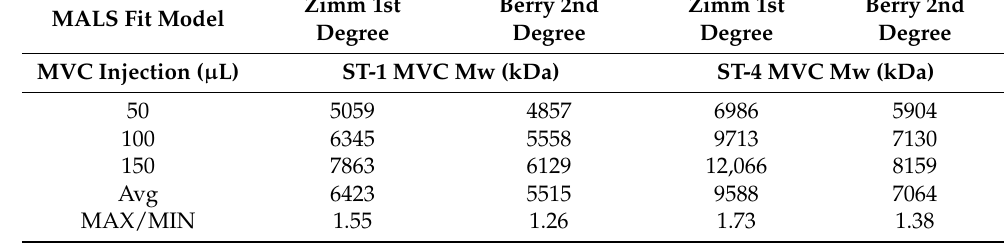
Figure 4. Zimm 1st order fit ( a ) vs. Berry 2nd order fit ( b ) for a ST-1 MVC on SEC-MALS. The red lines represent relationship between light scattering and angular function as described in Zimm and Berry formalisms.